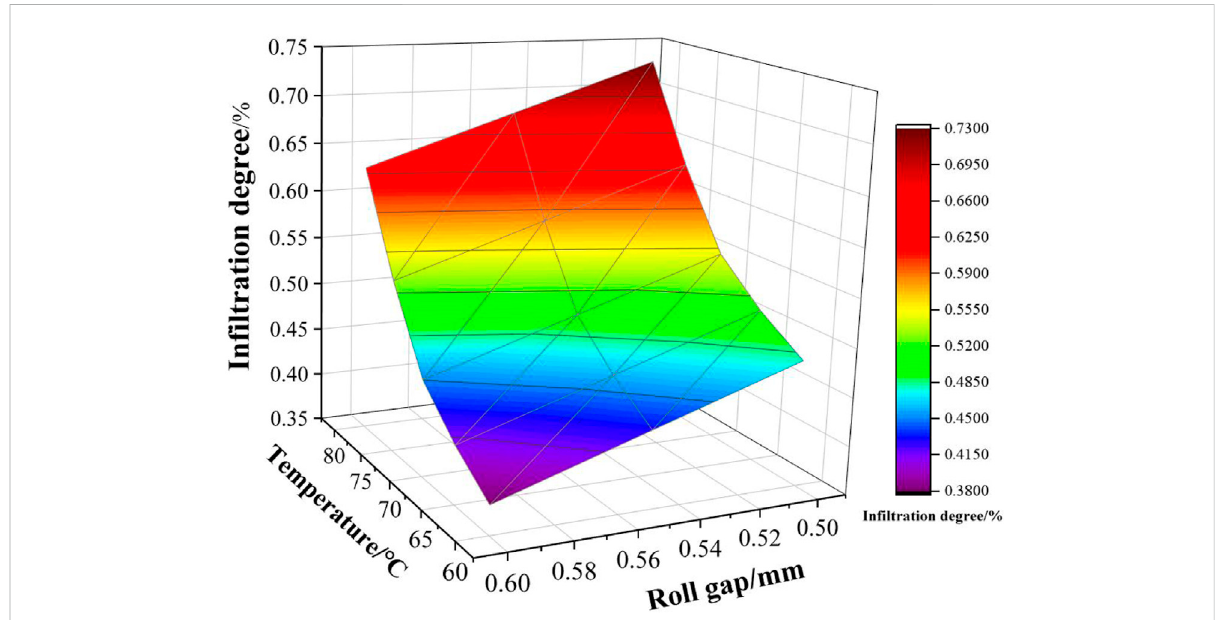
FIGURE 2 The relationship between the roll gap, the impregnation temperature and fi ber fabric in fi ltration degree.